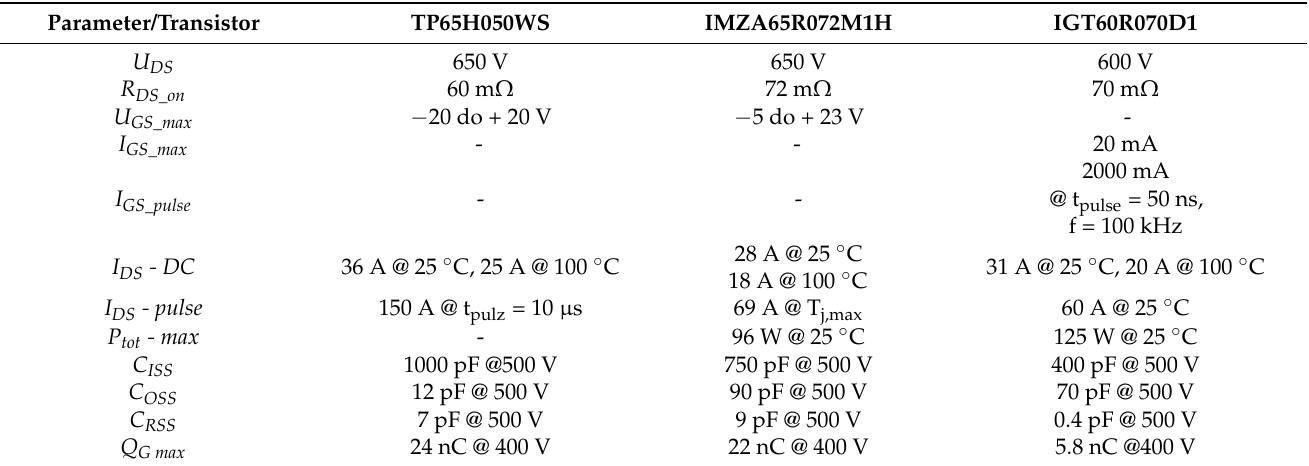
Table 8. Main electrical parameters of selected